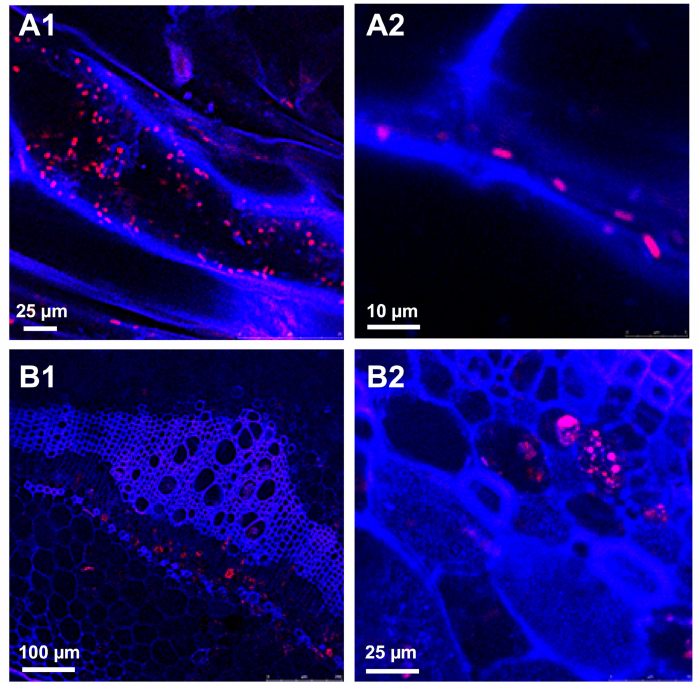
Figure 2. Colonization of potato roots and stems with DsRed-tagged Dickeya solani. DsRed fluorescent protein is a relevant alternative to the widely used green fluorescent protein (GFP) for tagging soft-rot Pectobacteriaceae . In this example, the peak emission of DsRed (610 nm), very far from that of the autofluorescence of plant cell walls (450 nm), allowed fine localization of D. solani IPO3012 (see Table 1) red cells and microcolonies, both in the blue cells and walls of the roots ( A1 , A2 ) and stems ( B1 , B2 ). For technical experimental details please see reference [125]. (Courtesy of Dr. Jan van